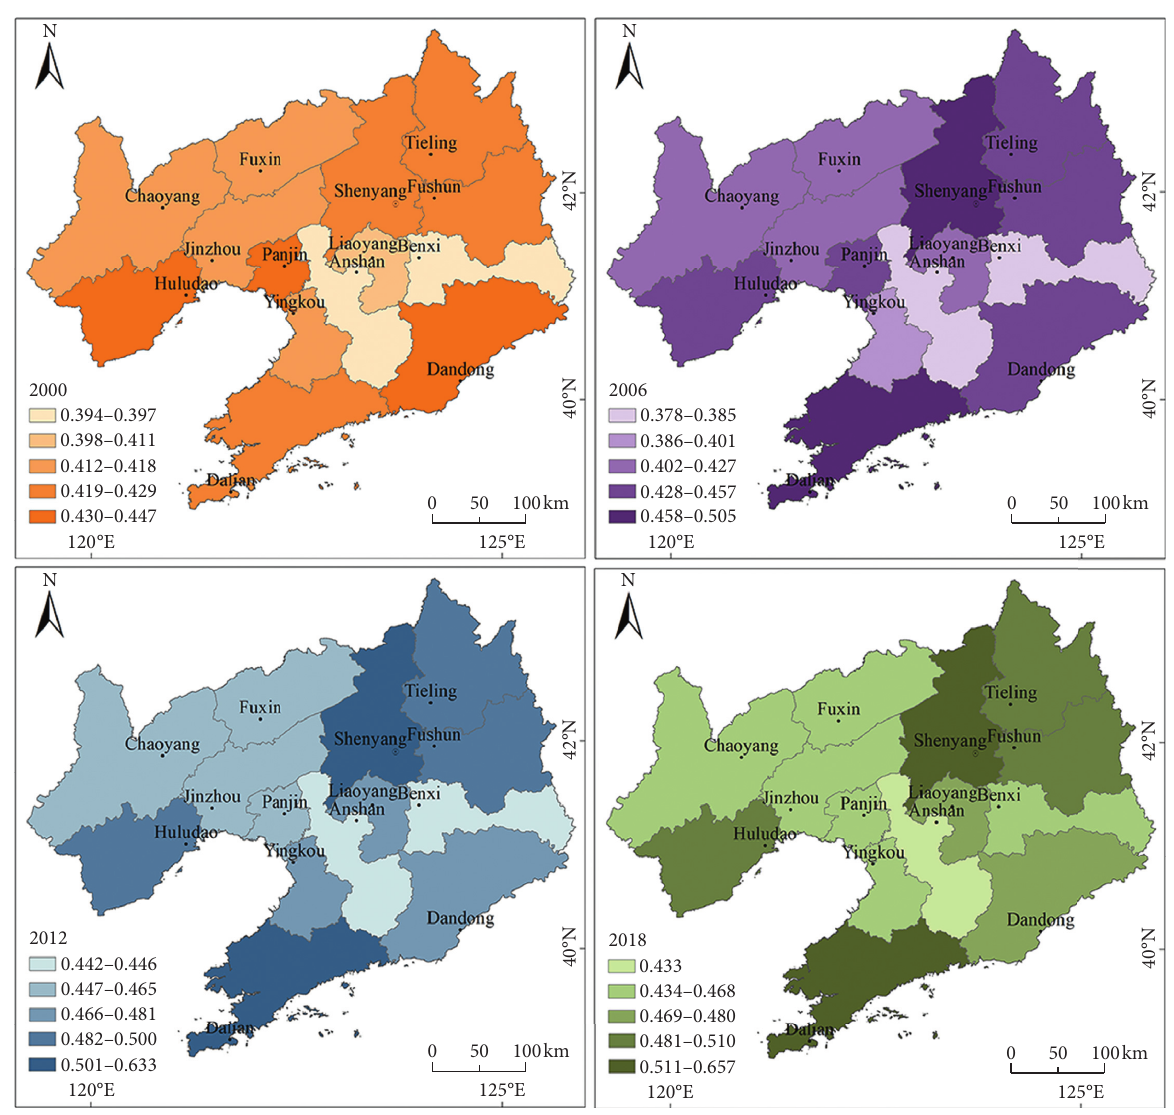
Figure 3: Spatiotemporal evolution patterns of urban industrial ecosystems development level in Liaoning